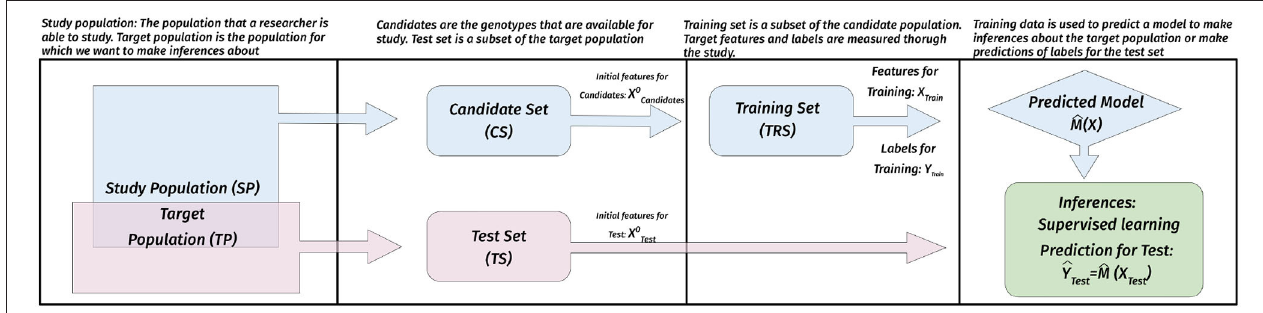
FIGURE 1 | Populations in STP and their use. The study population is the population that is accessible to the researcher. The candidate set (CS) is a countably finite representative subset of the SP, similarly, the test set (TS) is a countably finite representative subset of the target population. The initial information about the topology of the CS and TS ( X 0 Candidate and X 0 Candidate ) is used to identify a subset of the CS as the training set (TRS) for measuring the labels (phenotypic values in GS) ( Y Train ) and other related features ( X Train ) (for instance, environmental covariates). The training data for TRS is used to build supervised learning models which are then used to make inferences and predictions.